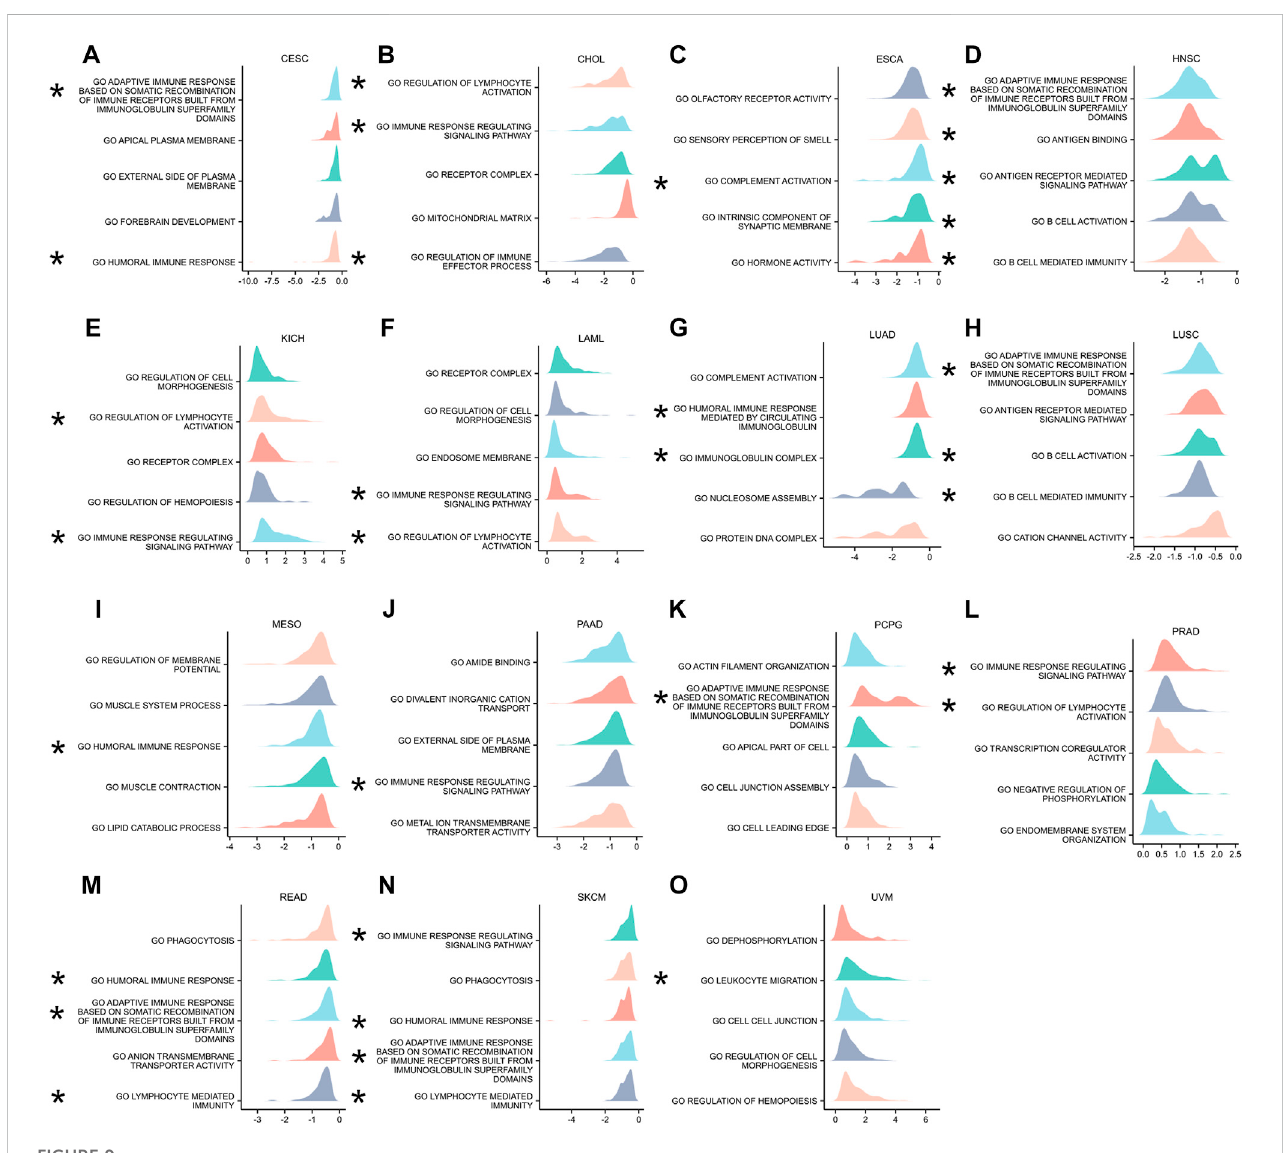
FIGURE 9 GSEA containing immune-related pathways. (A – O) The top fi ve GSEA terms identi fi ed in speci fi c tumor types.